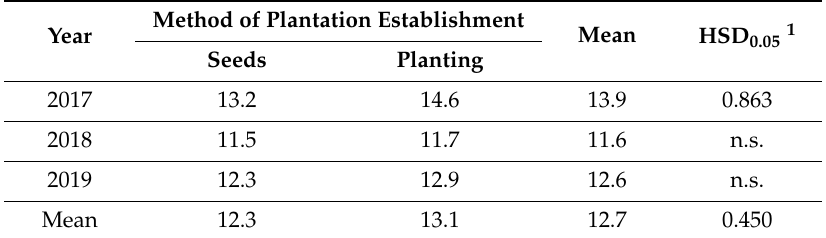
Table 7. The diameter of Silphium shoots (mm), depending on methods of plantation establishment.